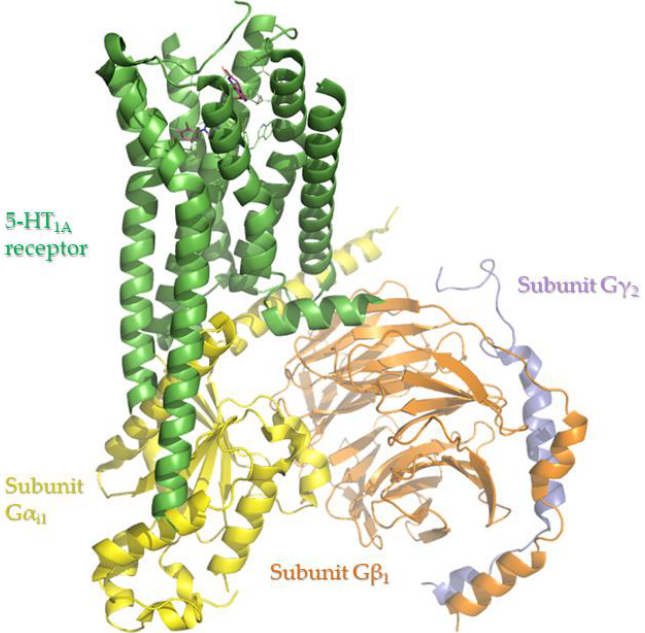
Figure 2. Crystal structure of the 7e2z PBD entry [7] of the 5-HT 1A serotonin receptor in green colored cartoon representation and the respective complexed G-coupled proteins subunit G α 1 in yellow, subunit G β 1 in orange and subunit G γ 2 in purple.